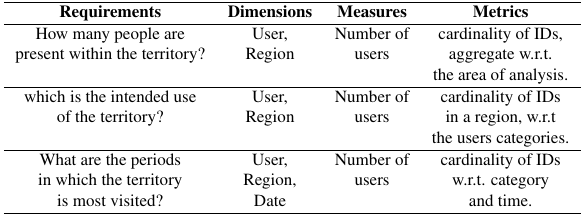
Table 1. Dimensions, measurements and metrics necessary to meet our requirements.